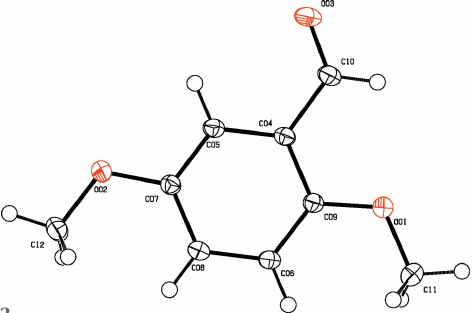
Figure 3 The molecular structure of 2,5-DMBz, showing displacement ellipsoids drawn at the 50% probability level.